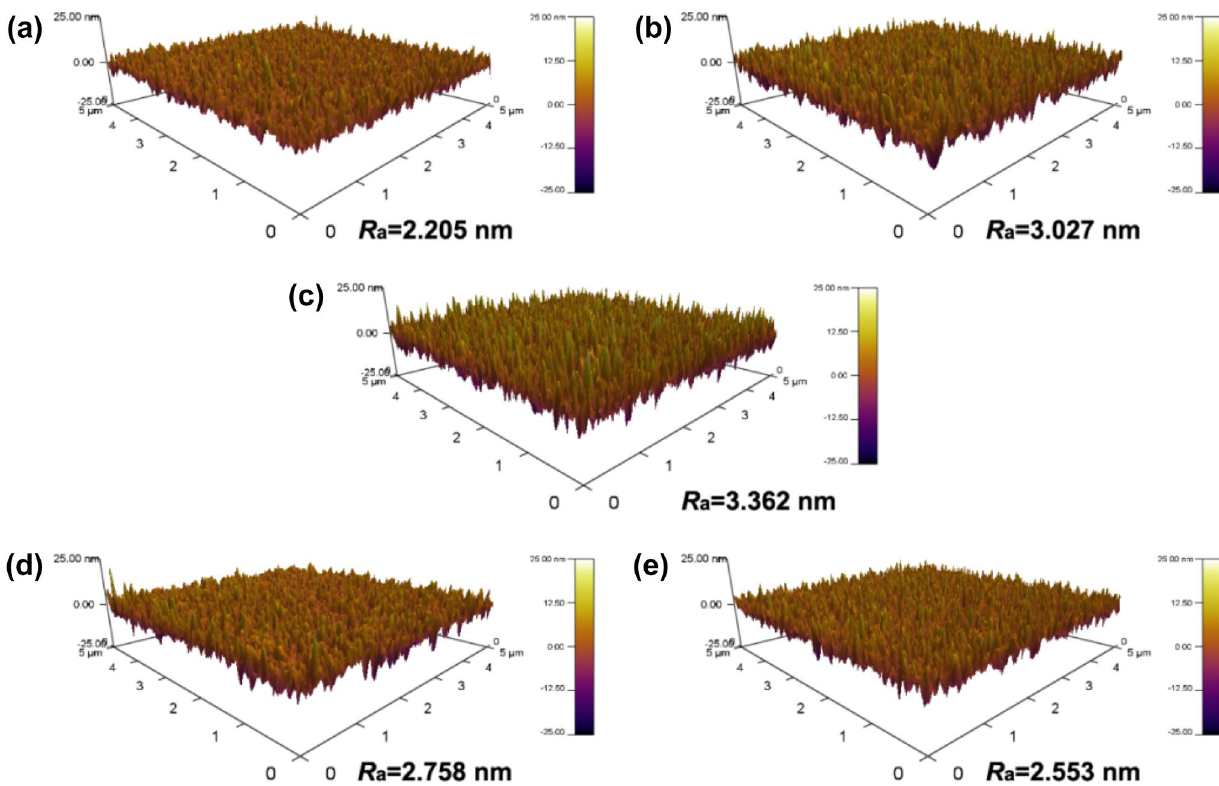
Fig. 3 Three-dimensional AFM images for TiN thin films deposited under different N